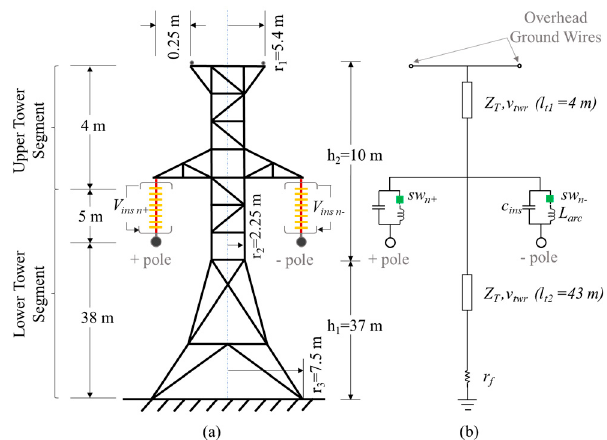
Figure 2. Overhead section of mixed HVDC transmission line. ( a ) Structure. ( b ) Fast front model for electromagnetic transient (EMT) simulation (description of symbols is provided in Table 1 and Equation (1)) [15].